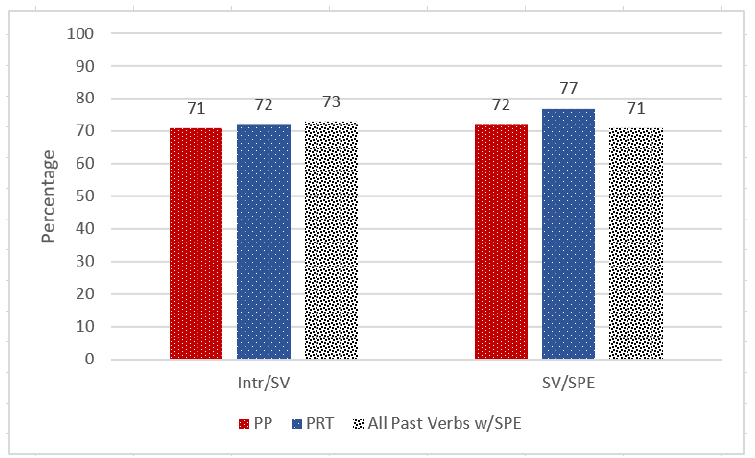
Figure 5 . Expressed subjects by past verbal form, word order, and valency